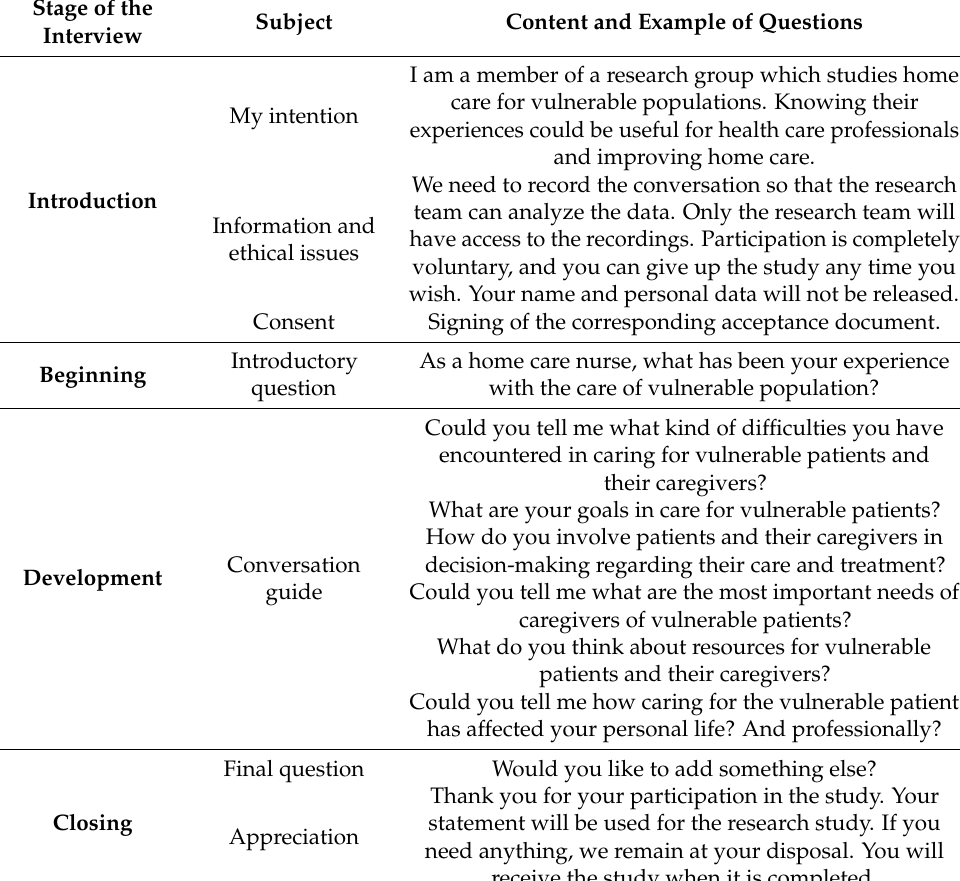
Table 2. Interview